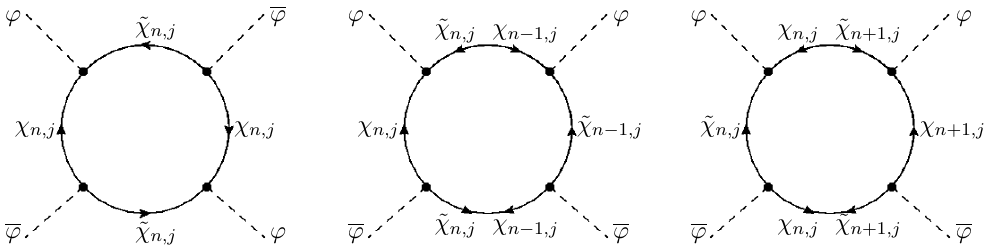
Figure 5. Fermionic contributions to the Wilson line quartic coupling with (cid:13)ux.